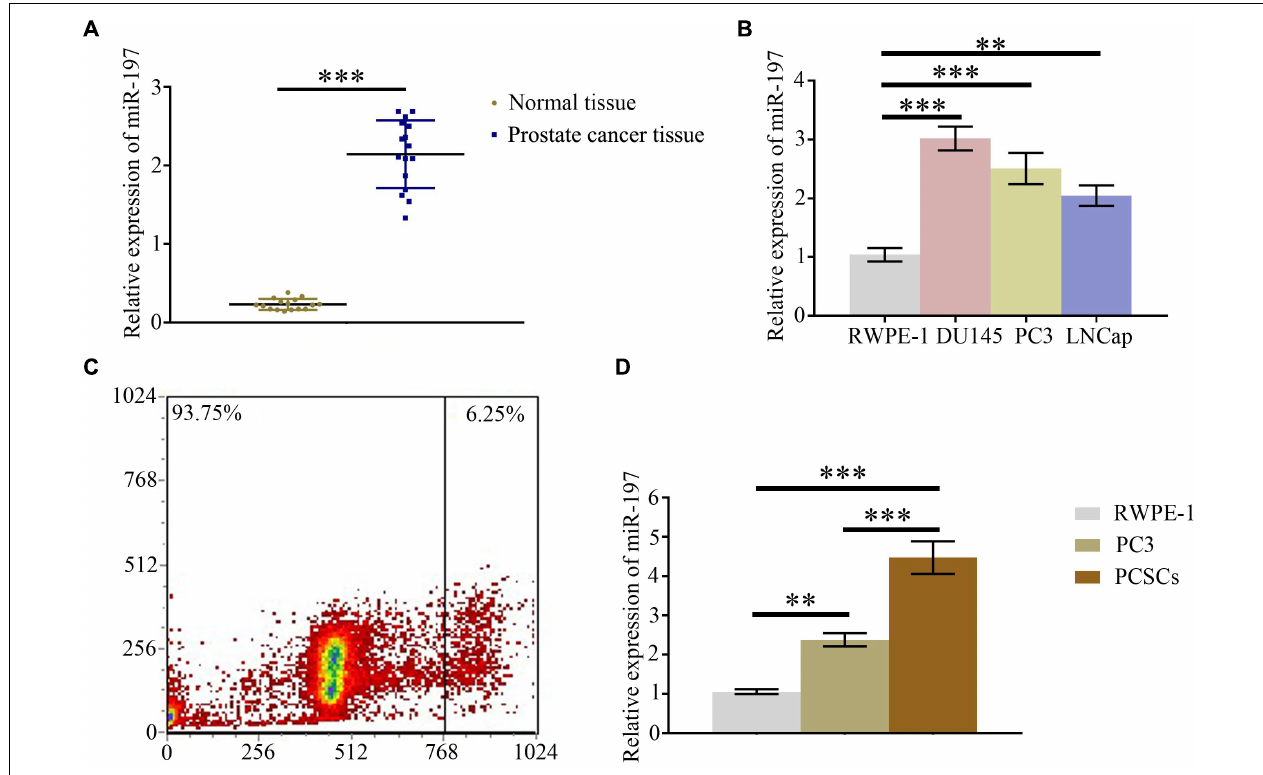
FIGURE 1 | MiR-197 is overexpressed in prostate cancer tissues and prostate cancer cells. (A) qPCR assay was used to detect the expression of miR-197 in prostate cancer tissues and different prostate cancer cells. (B) qPCR assay was used to determine the expression of miR-197 in prostate cancer cells lines (RWPE-1, DU145, PC3, and LNCaP). (C) CD133 overexpressing PC3 cells were selected using flow cytometry. (D) qPCR assay was used to detect the expression of miR-197 in RWPE-1, PC3, and prostate cancer stem cells (PCSCs). * p < 0.05, ** p < 0.01, *** p < 0.001.